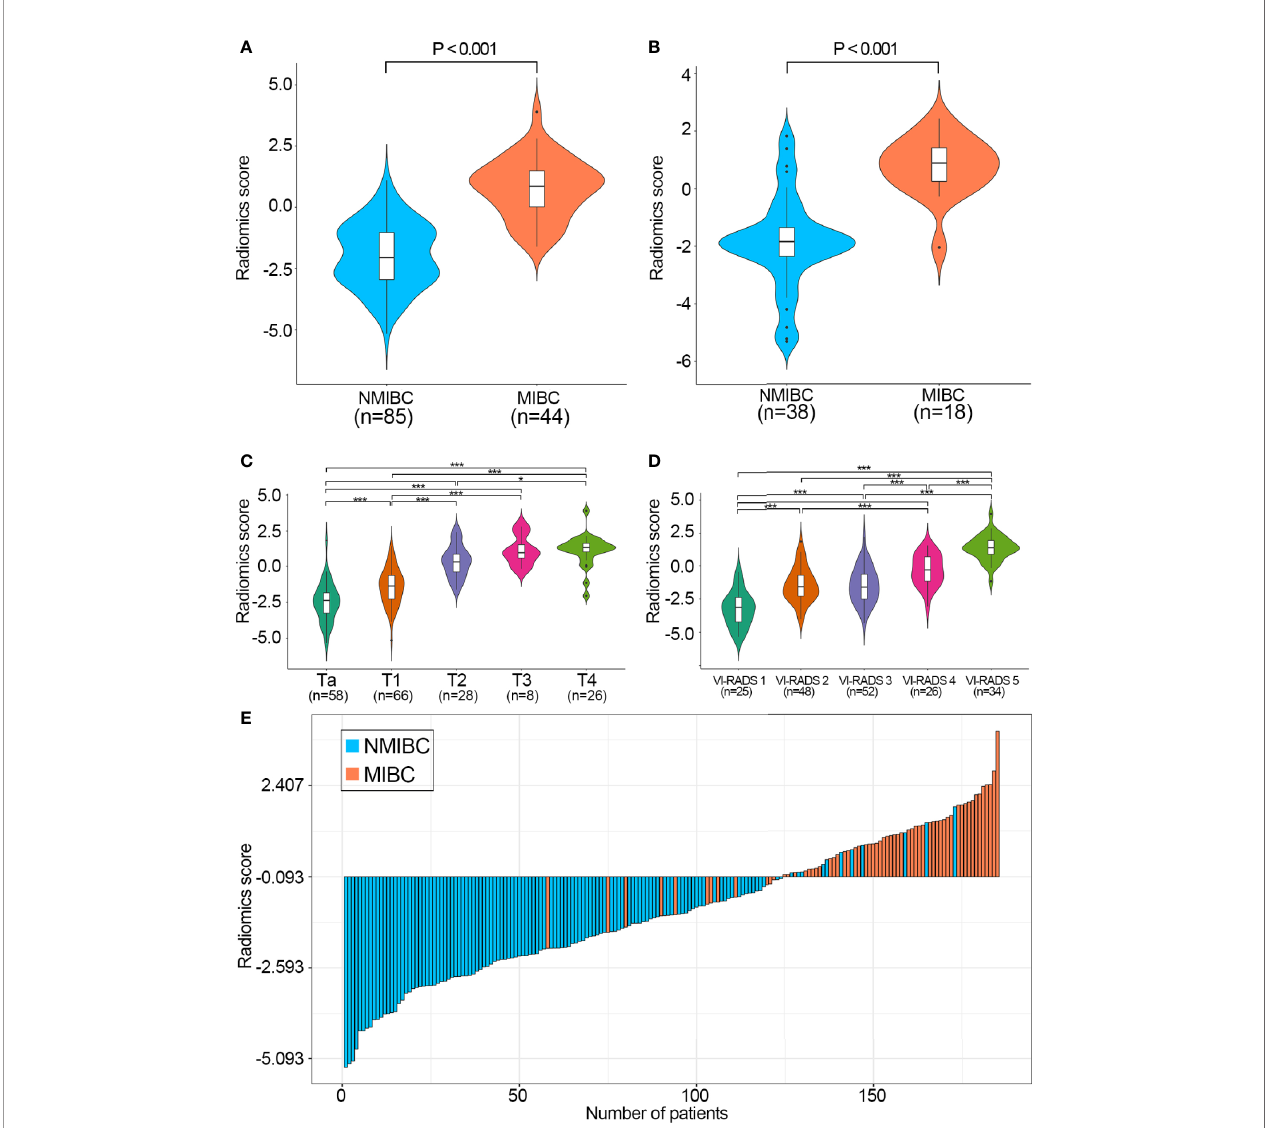
FIGURE 5 | Performance of the radiomics score calculated by the LASSO classi fi er. Boxplots of the radiomics score in the training (A) and validation sets (B) grouped by the muscle-invasive status. Boxplots of the radiomics score in the combined training and validation set grouped by T stage (C) and VI-RADS score (D) , respectively. P values were calculated using one − way ANOVA followed by Dunnett ’ s post − hoc test. (E) Waterfall plot of the distribution of radiomics scores and pathologic tumor stages of individual patients in the combined training and validation sets. LASSO, least absolute shrinkage and selection operator; VI-RADS, Vesical